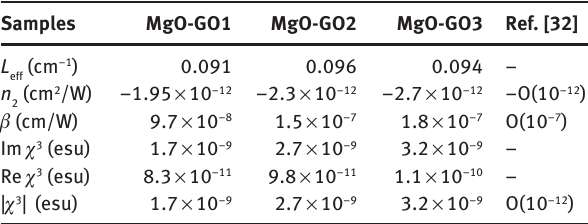
Figure 6: Closed-aperture of the Z-scan experimental curves of MgO-GO samples synthesized at various temperatures. Table 2: NLO parameters of GO-doped MgO samples. Samples